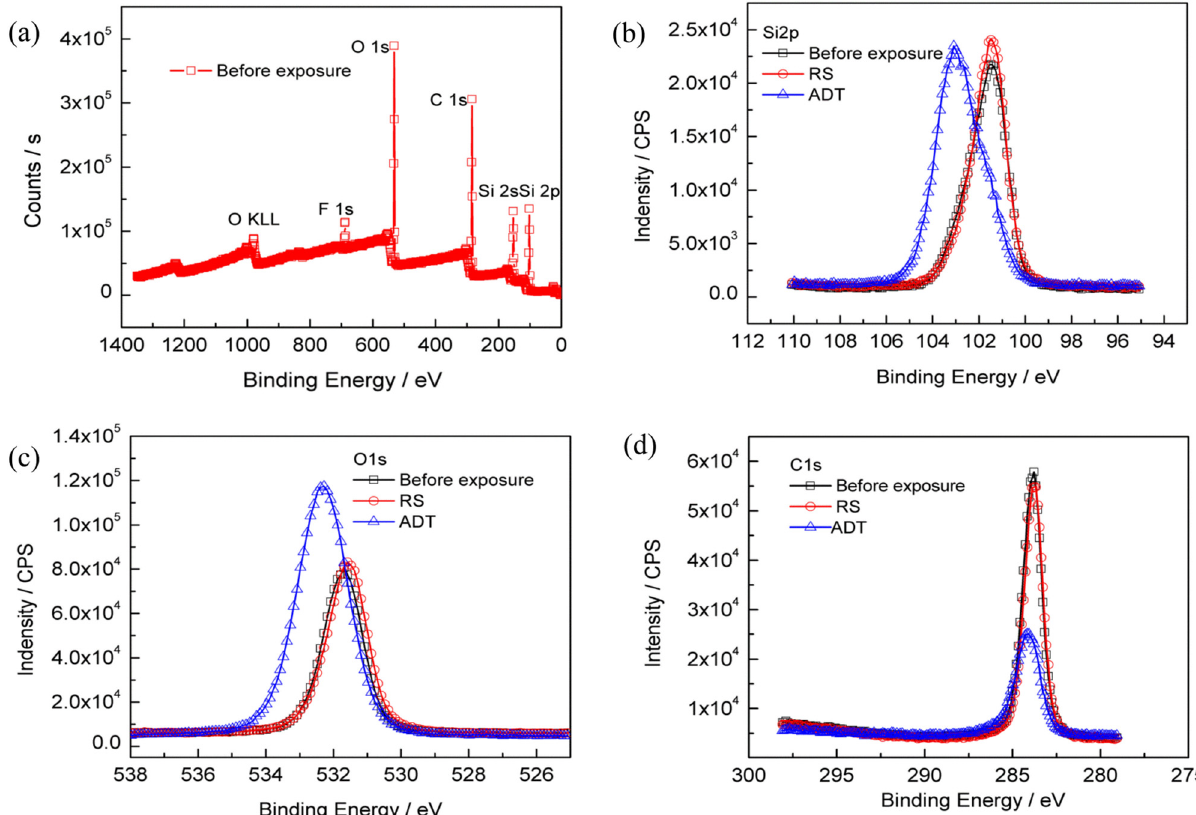
Figure 4: XPS spectrum and high - resolution spectra analysis for the specimens: ( a ) XPS spectrum for unexposed specimens, ( b ) high - resolution spectra - Si2p, ( c ) high - resolution spectra - O1s, and ( d ) high - resolution spectra -